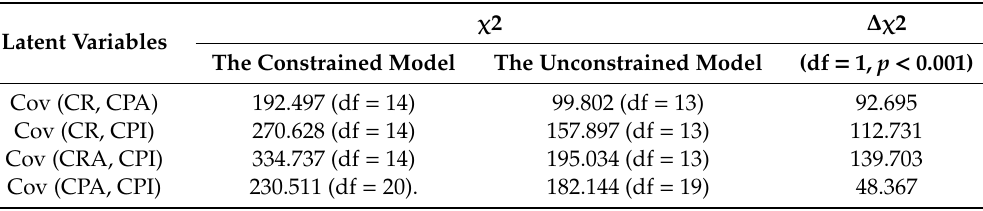
Table 3. Chi-square di ff erence value